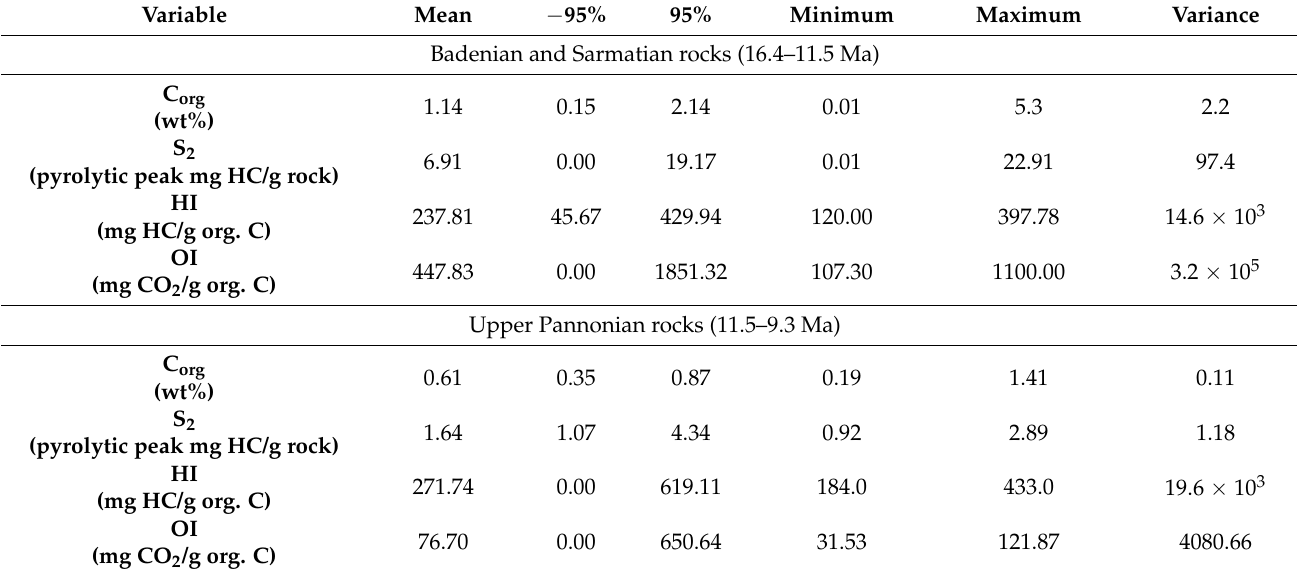
Table 1. Geochemical variable values in potential source rocks in the Bjelovar Subdepression, Croatia [16]. Variable Mean − 95% 95% Minimum Maximum Variance Badenian and Sarmatian rocks (16.4–11.5